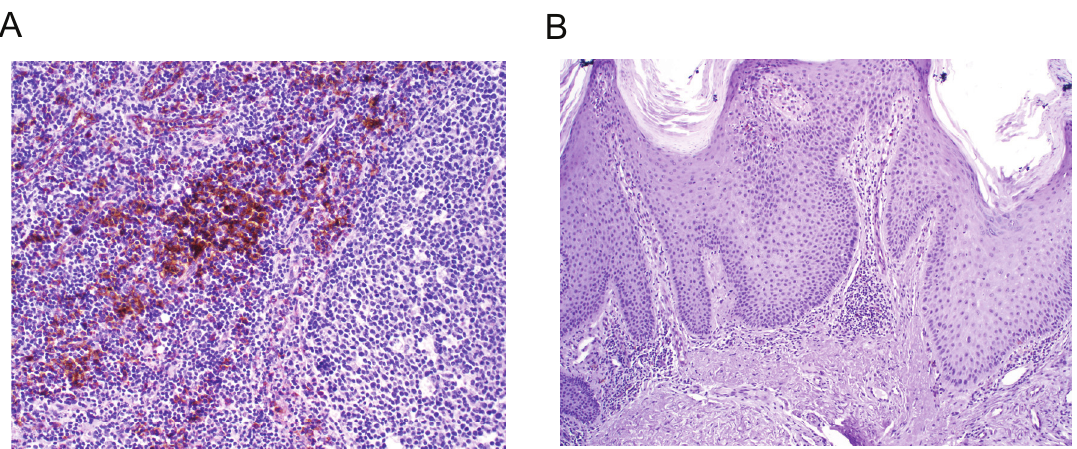
Figure 3. ( A ): Example of positive CD123 immunohistochemical stain from tonsil control tissue (200× magnification). ( B ): CD123 immunohistochemical stain on the biopsy of hypertrophic lupus erythematosus from the reported patient. Only rare plasmacytoid dendritic cells are seen in the dermis. The stain is negative for the dense band of CD123 positive cells that Ko et al. described in hypertrophic lupus erythematosus (100×